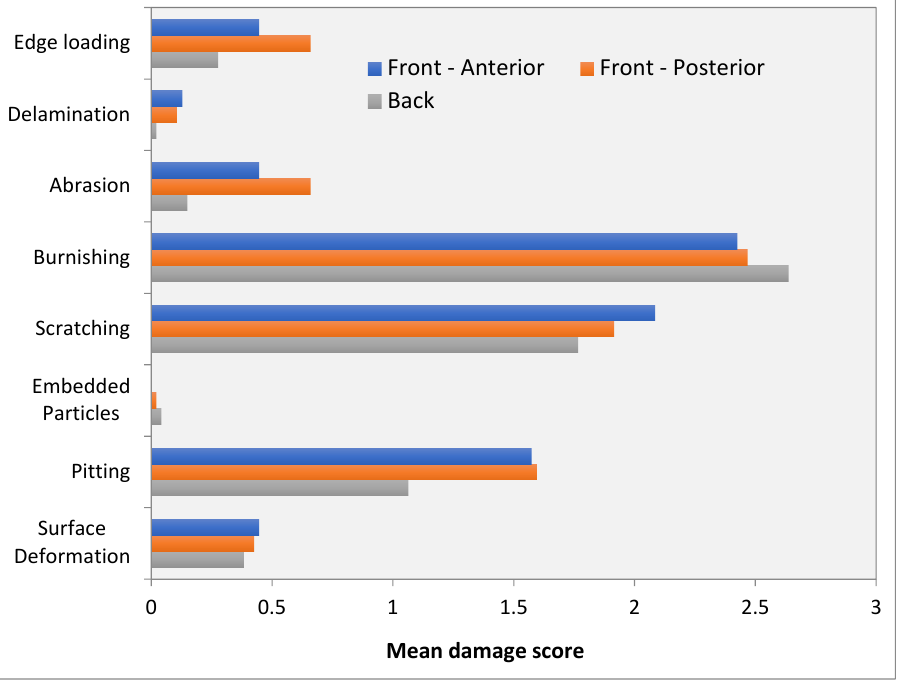
Figure 3. Hood damage score for all parts of the inlay (front-anterior and -posterior;